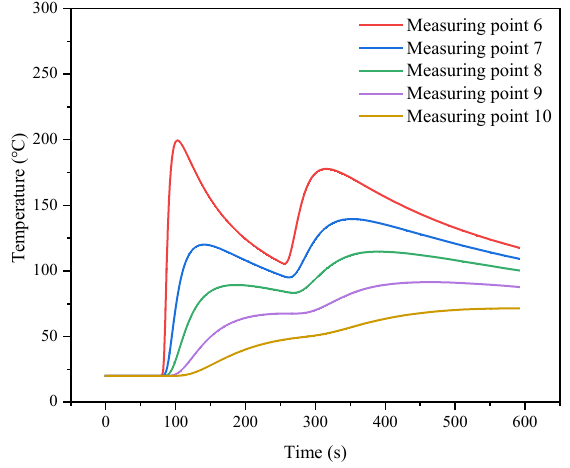
Figure 14. Temperature history curve of path 2.